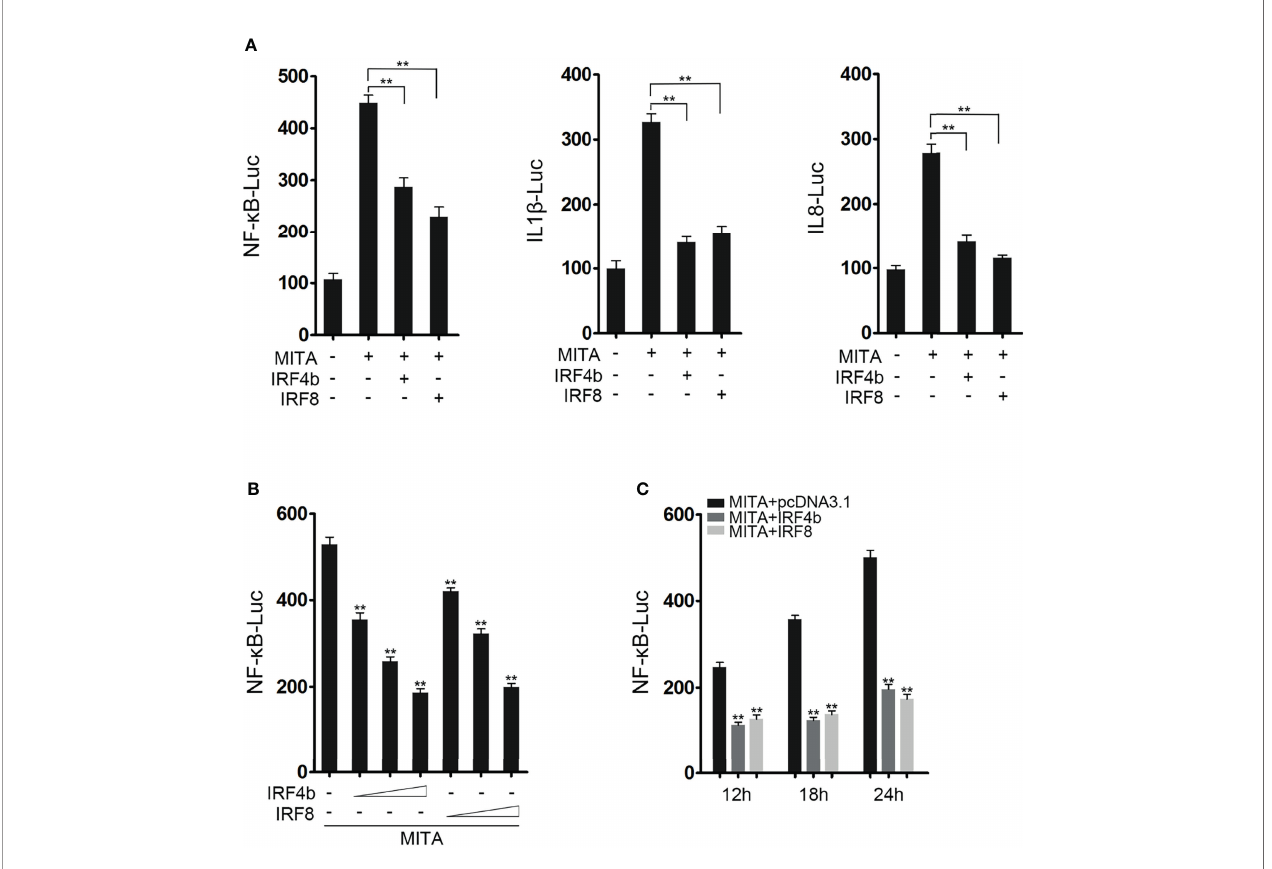
FIGURE 2 | IRF4b and IRF8 negatively in fl uence the MITA-mediated NF- k B signaling pathway. (A) EPC cells were seeded onto 24-well plates overnight and cotransfected with MITA, pcDNA3.1, IRF4b, IRF8, and the reporter genes such as NF- k B (left), IL-1 b (middle), and IL-8 (right), respectively. The dose of each plasmid was 0.2 m g (0.25 m g for every kind of reporter gene). Luciferase activity was measured at 24 h after transfection. (B) The concentration gradient experiments of IRF4b and IRF8 were performed in the following doses: 0.05, 0.1, or 0.2 m g, and MITA and NF- k B were also transfected into EPC cells. The cells were lysed at 24 h for luciferase reporter assays. (C) MITA, IRF4b, IRF8, and the reporter gene of NF- k B were transfected into EPC cells, and the cells were randomly divided into three groups according to the different time points. After being lysed at 12, 18, and 24 h, luciferase reporter assays were performed. ** p < 0.01. All the experiments were performed independent at least three